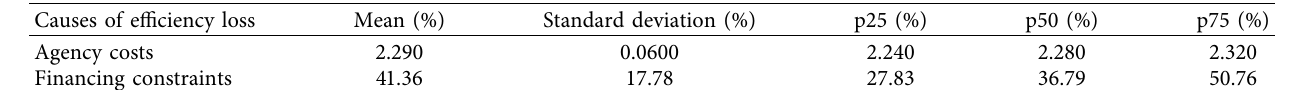
Table 5: Estimation of loss of efciency in the infrastructure